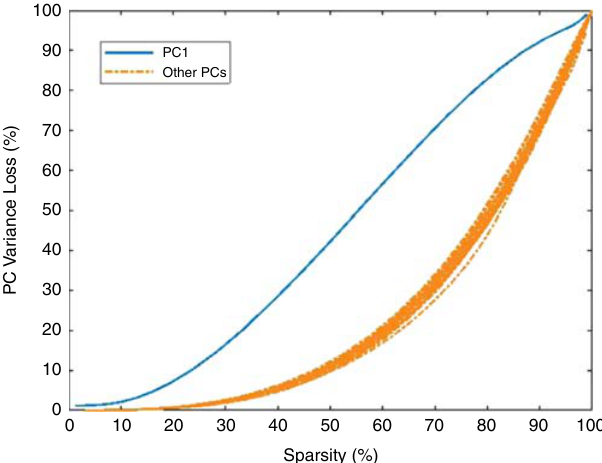
Figure 3. Variance loss of first 25 eigenvectors (principle components) as a function of sparsity